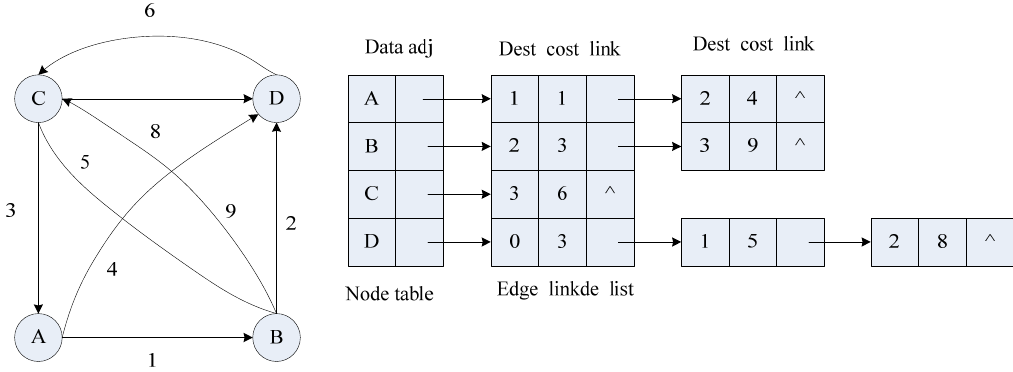
Figure 3. Adjacency list representation of a graph.